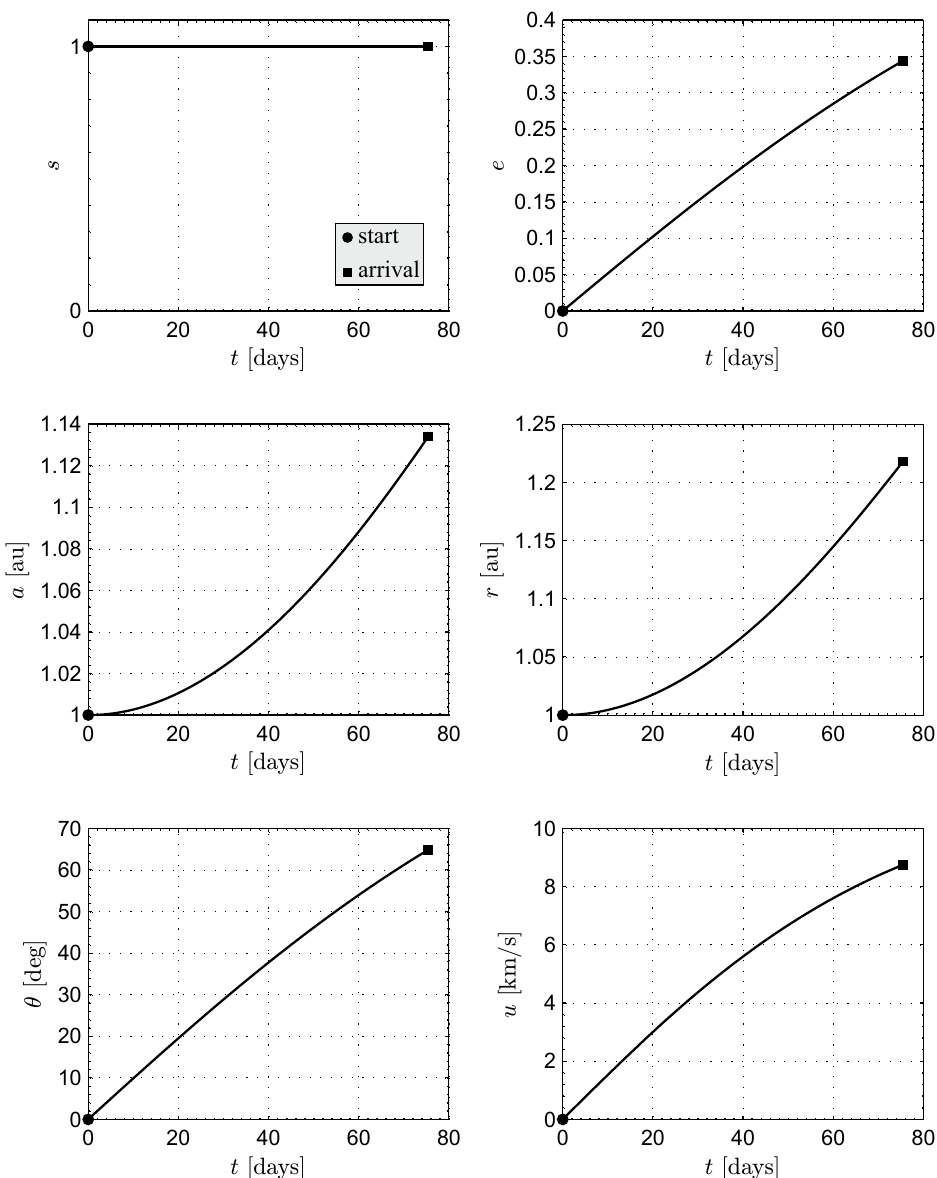
Figure 12. Transfer trajectory characteristics in a Mars-based mission scenario with e f = 0.3438 and β =